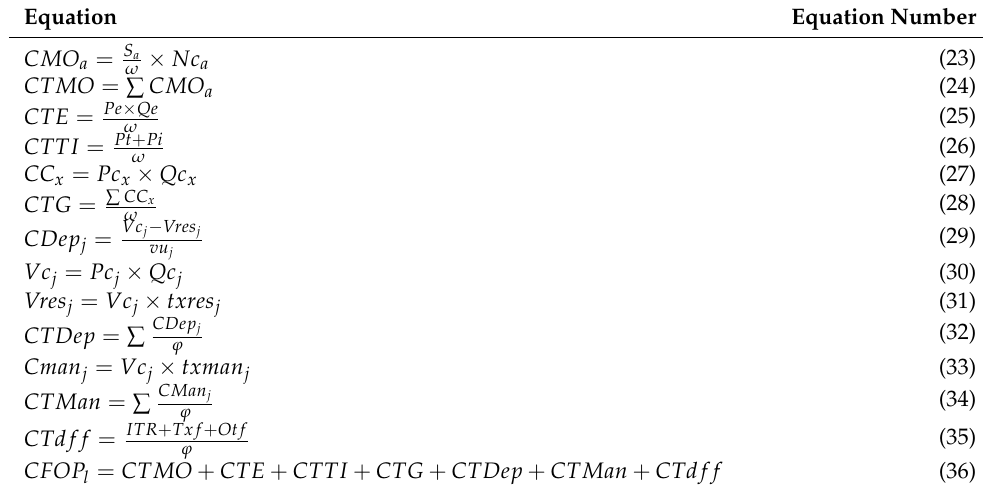
Table 4. Equations that make up the fixed operating costs that compose the cost calculation model for swine production.